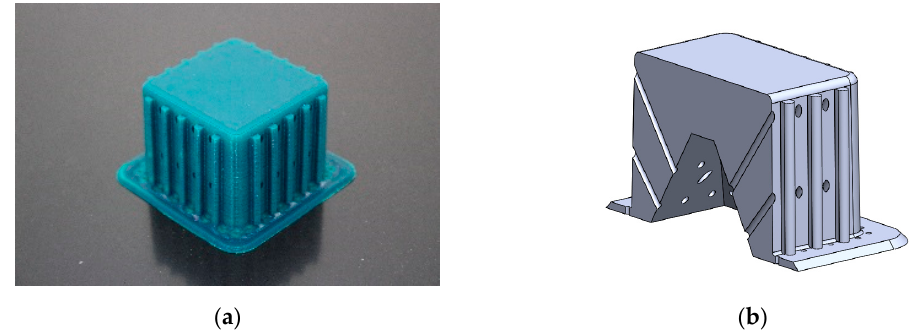
Figure 4. Example images of the mould used for thermoforming compression specimens: ( a ) image of the mould, ( b ) vacuum channels included inside the mould.